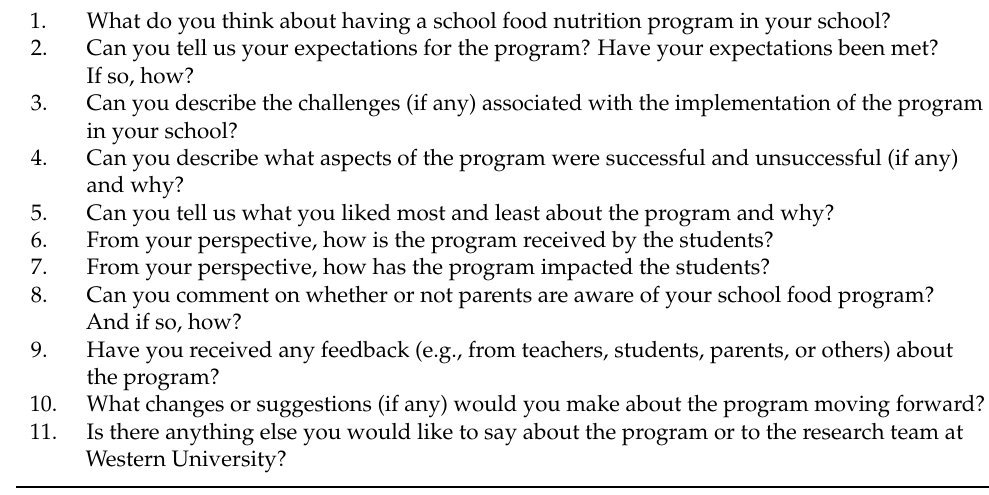
Table 1. Interview guide for food